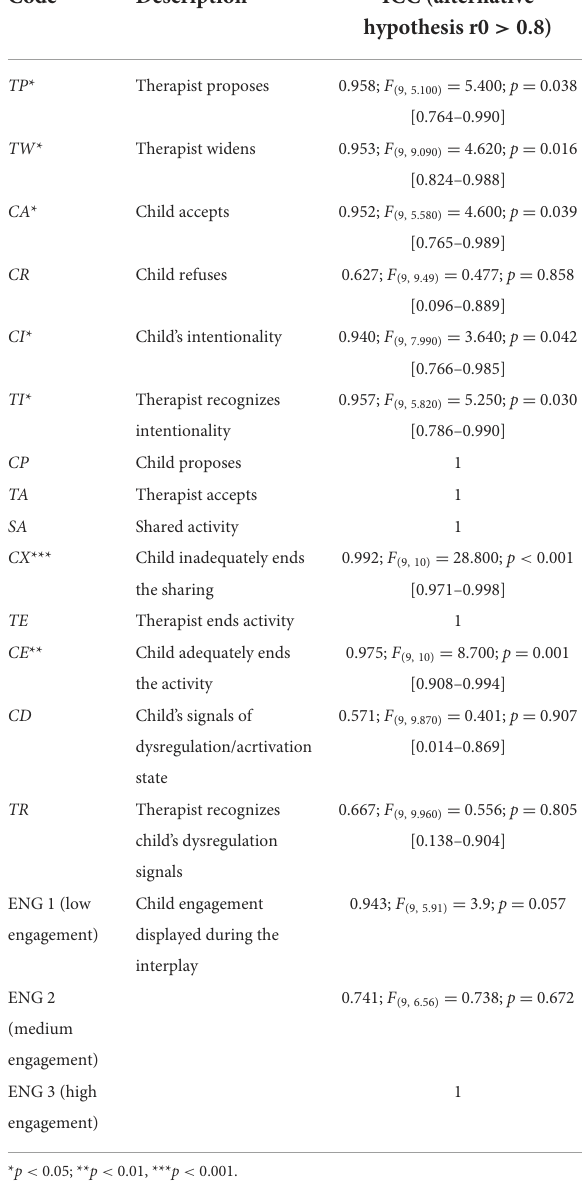
TABLE 1 Coding schema of the observational code and interclass correlation coefficient for each code (30).